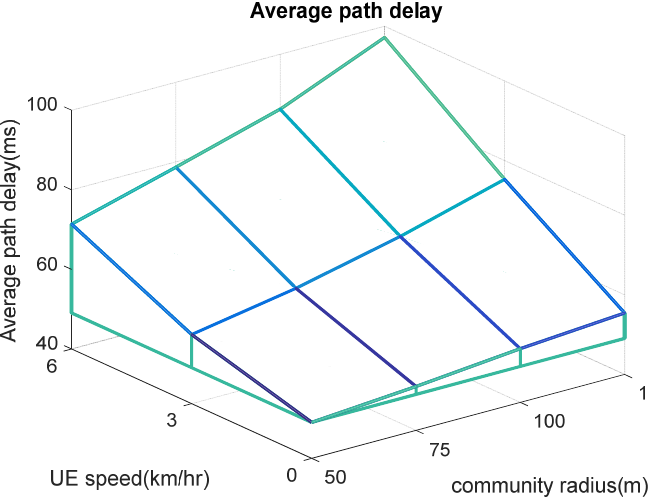
Figure 23. Delay vs. group size and UE’s moving speed.